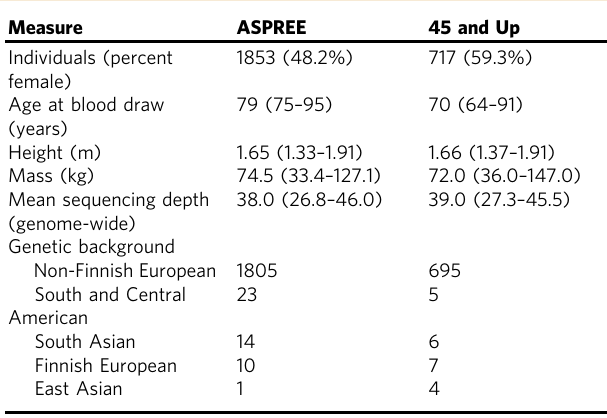
Table 1 Summary metrics for the fi rst release of the MGRB well elderly